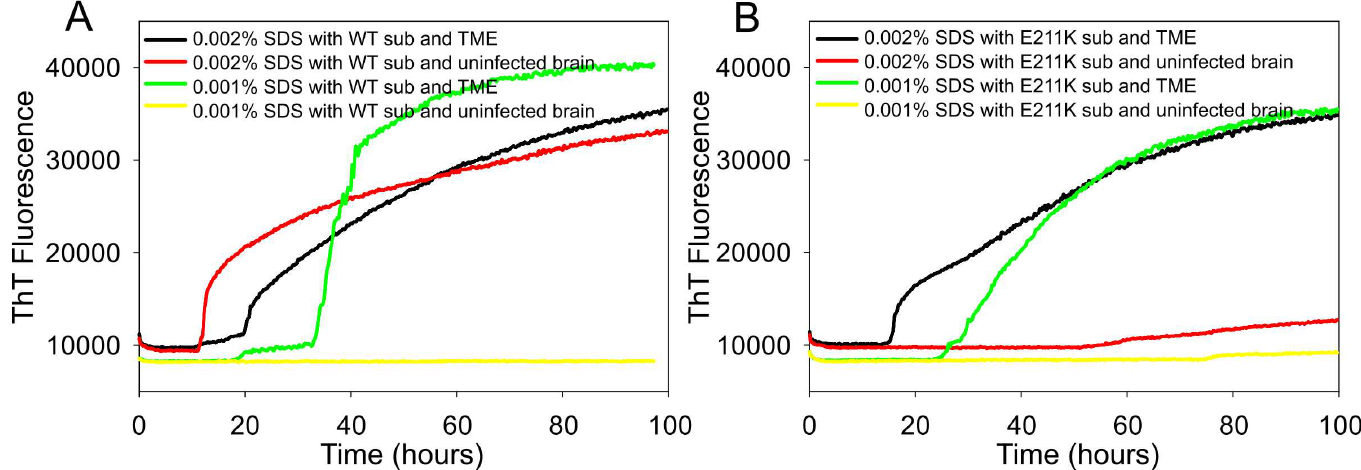
Fig 4. Comparison of SDS dependency of RT-QuIC reactions using full-length (A) bPrP wild type or (B) bPrP E211Kas the substrate. RT-QuIC reactionswere seededwith 10 − 4 dilutionsof TME infected cattle and negative control (uninfectedcattle) brain homogenates using either full-lengthbPrP wild type or E211K protein (aa 25–241) as substrates with the additionof 0.001%or 0.002% SDS (final concentration). Data are presentedas meanThT fluorescence of 8 reactions conductedas 2 repeatsof 4 reactions.The positivethreshold was calculateas ~10,000relativefluorescence units of normalcattle brainhomogenates.